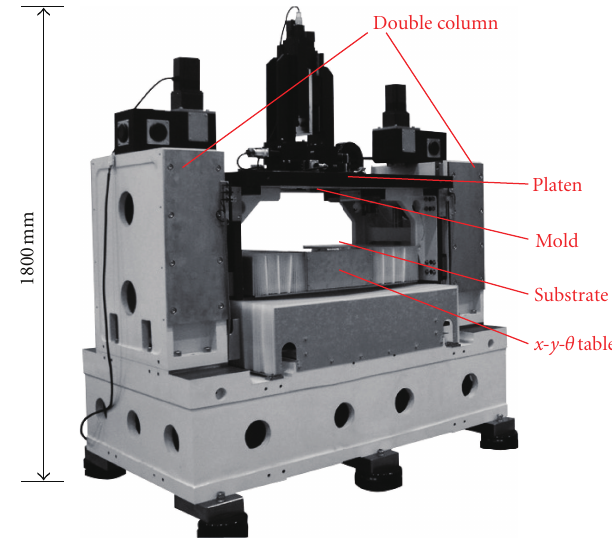
Figure 2: Nanoimprinting system: this system consists of a press platen in a double-column frame and an x - y - θ table. The quartz mold was fixed under the press platen, and the substrate was fixed on the x - y - θ